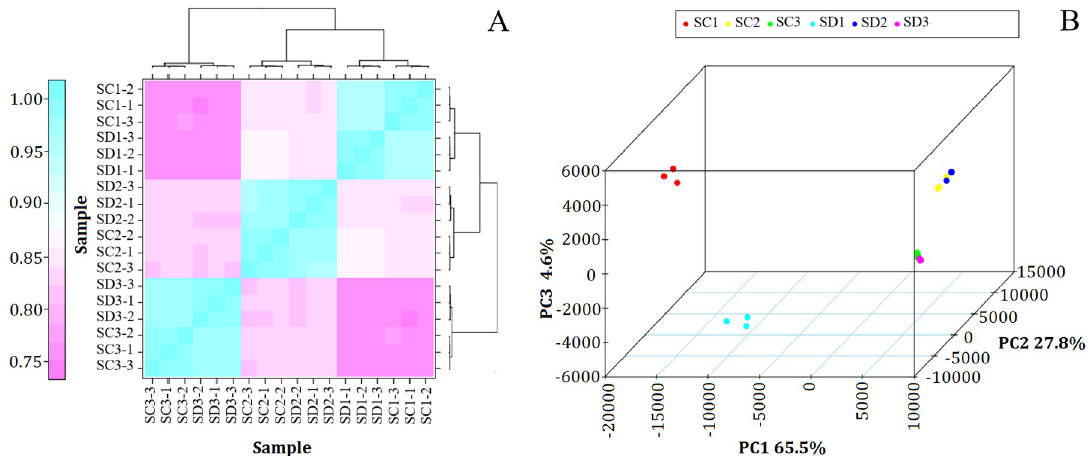
Fig 3. Principal component analysis (A) and cluster analysis (B) of transcriptome data. Three biological replicates per sample were analyzed for each development stage. The percentages on the axes indicate the values explained by each PCA; and the dots of the same color represent the transcriptomes of the samples obtained from the same shoot type at the same